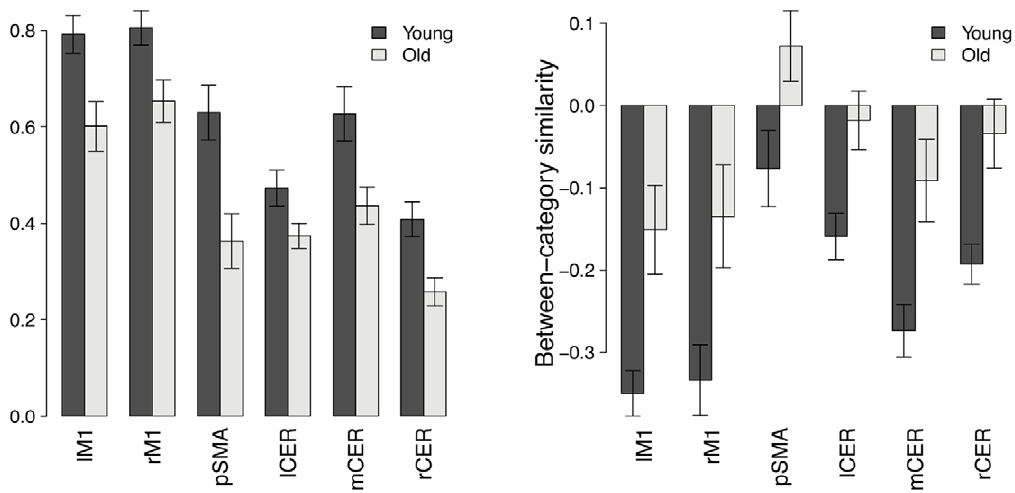
Figure 3. Region-of-interest analysis of within- and between-category similarity in the motor network. Older adults showed reduced within-category similarity (left panel) and increased between-category similarity (right panel) throughout the motor network. Error bars denote the standard error of the mean.